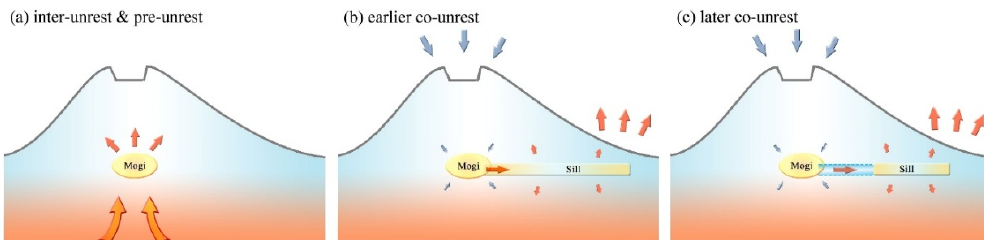
Figure 5. Schematic diagram of magma delivery in the magma model along profile A-A’. ( a ) Magma upwelled and accumulated in the Mogi chamber during the long period of inter-unrest and pre-unrest. ( b ) The Mogi source contracted while the Sill source inflated in the co-unrest period in interferograms III and IV, and magma was delivered from Mogi to Sill through the adjacent rifts. ( c ) The Mogi source contracted continually while the Sill source inflated, diffused and deformed in the co-unrest period in interferograms V and VI, while the remains of the ancient Sill channel served as corridor of magma delivery.